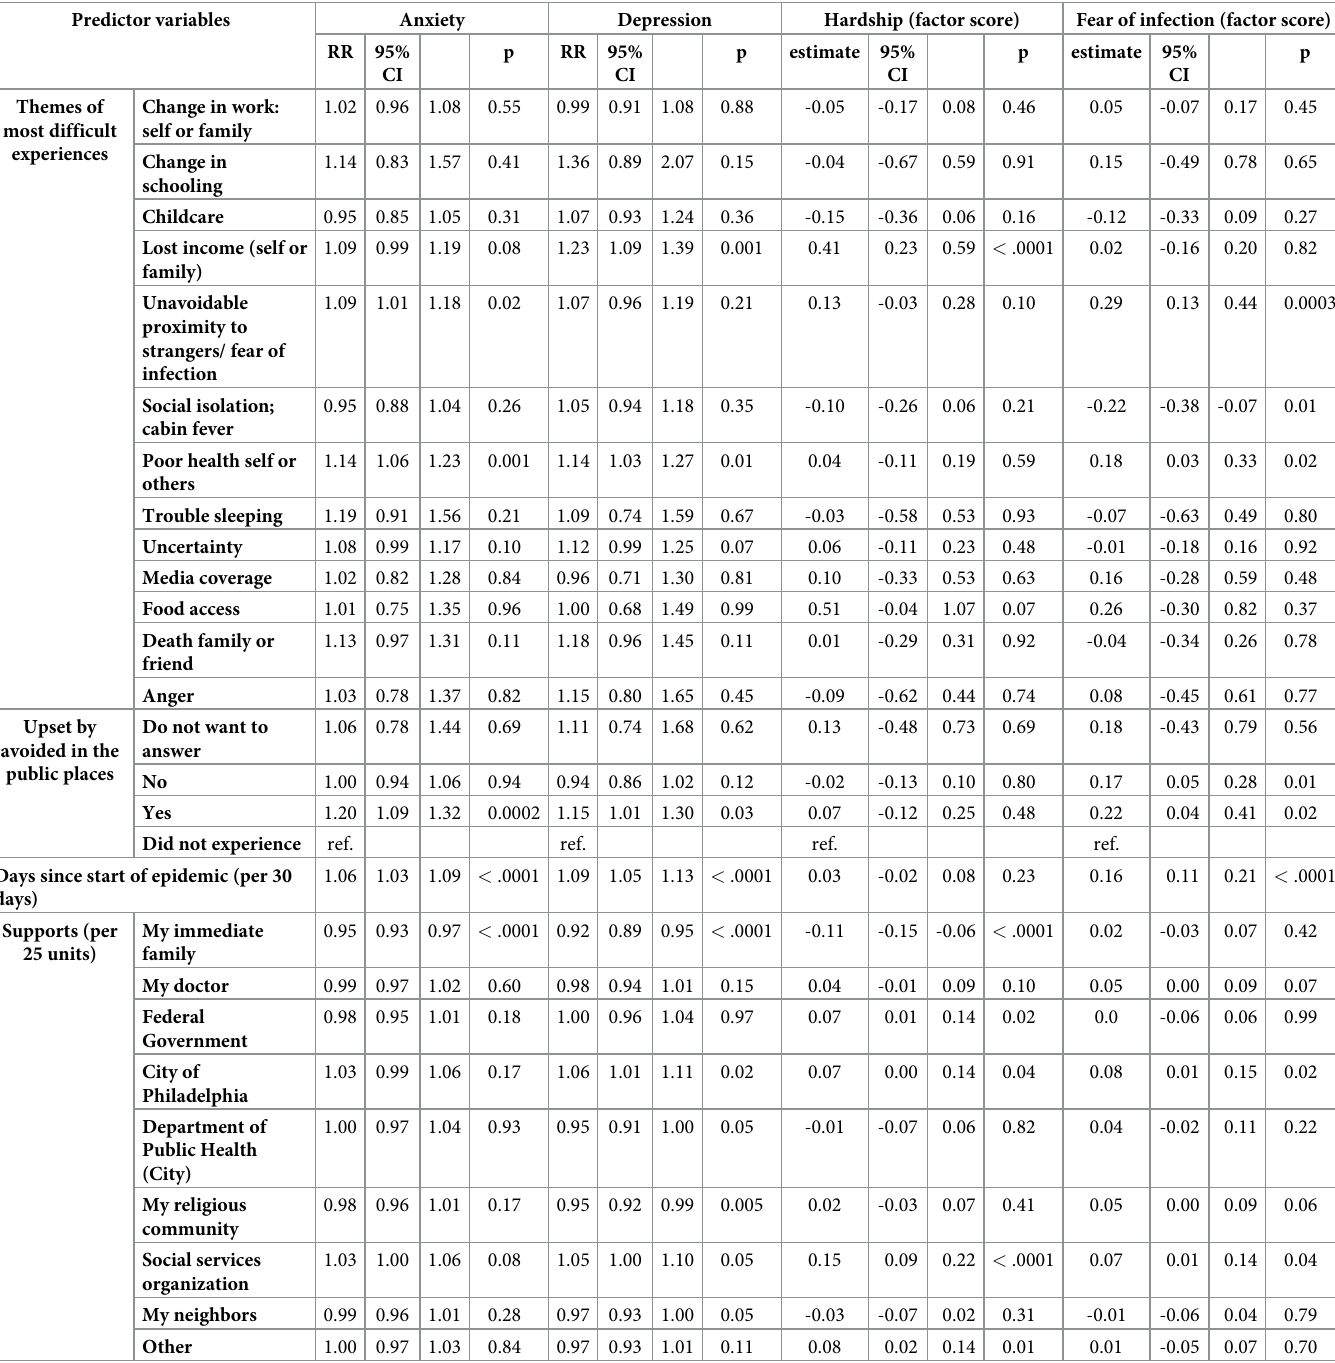
Table 4. Estimated coefficients of multiple regression models relating experiences of 1,293 participants in survey of adult residents of Philadelphia, PA, during the first wave of COVID-19 epidemic to (a) Hospital Anxiety and Depression Scale scores via negative binomial regression and (b) measures of hardships and fear of infection assessed by factor scores computed from reported specific worries via linear regression; RR: relative rates of change in one unit on the scale; CI: confidence intervals; p: p-values for the test of no association; all displayed estimates are mutually adjusted and account for gender, race, age, personal income, education, mar- ital status, children < 18 at home (there was no material change on further adjustment for employment, self-reported general health; comments on effect modifica- tion by gender are in